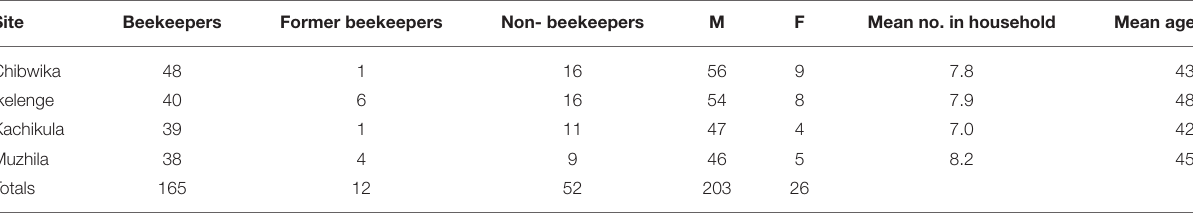
TABLE 2 | Respondents and demographics, disaggregated by site.